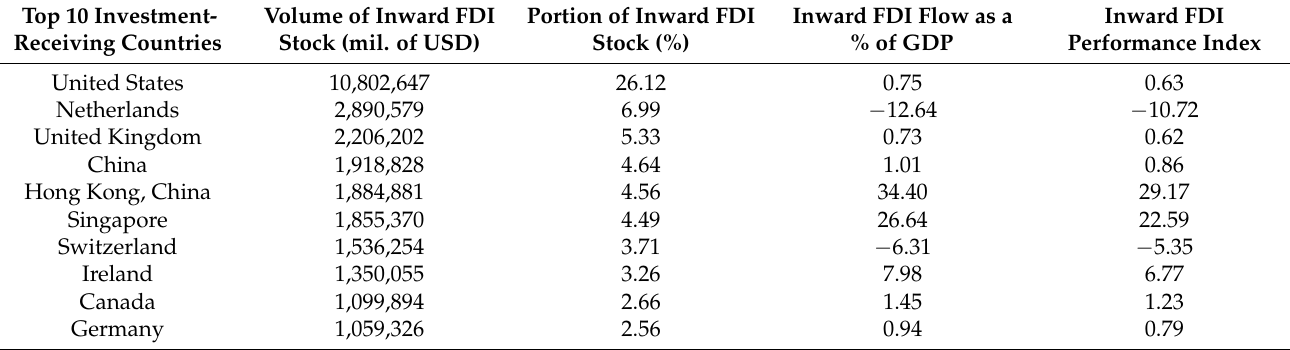
Table 2. Selected inward FDI indicators of top 10 investment-receiving countries (own processing based on data from [40,47]). Top 10 Investment- Receiving Countries